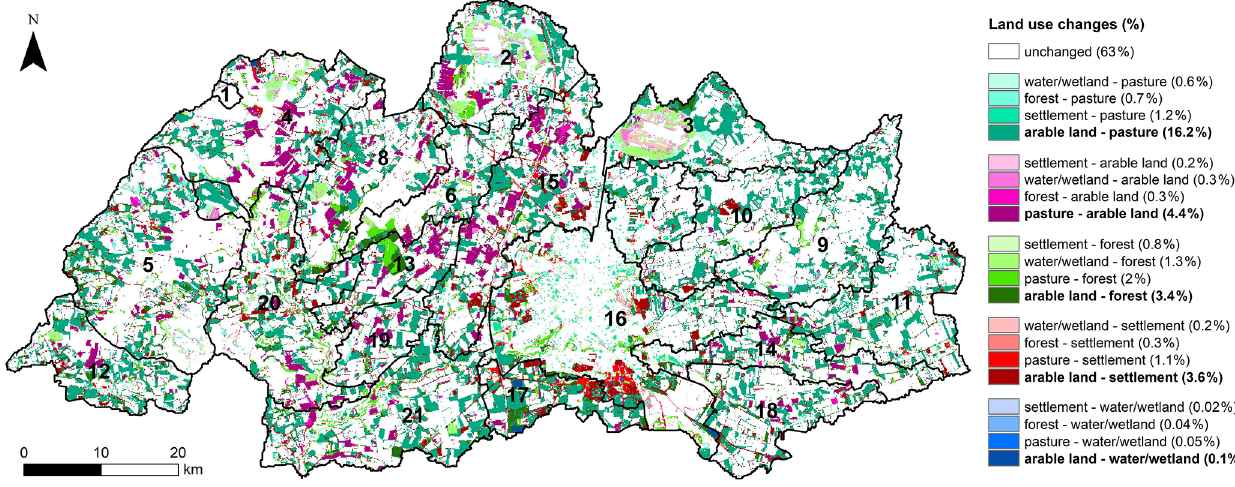
Figure 4. Spatial distribution of land use changes between 1987 and 2019 in the Stör catchment. Individual land use change types are marked by different colors. The percentage of each change type, calculated as percentage of the catchment area, is given in the parentheses. The strongest change is marked in bold.